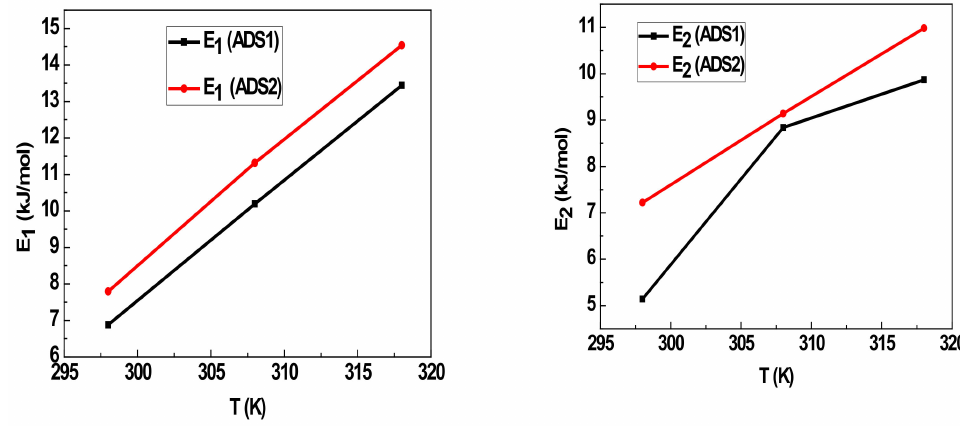
Figure 5. Trend of adsorption energies as a function of